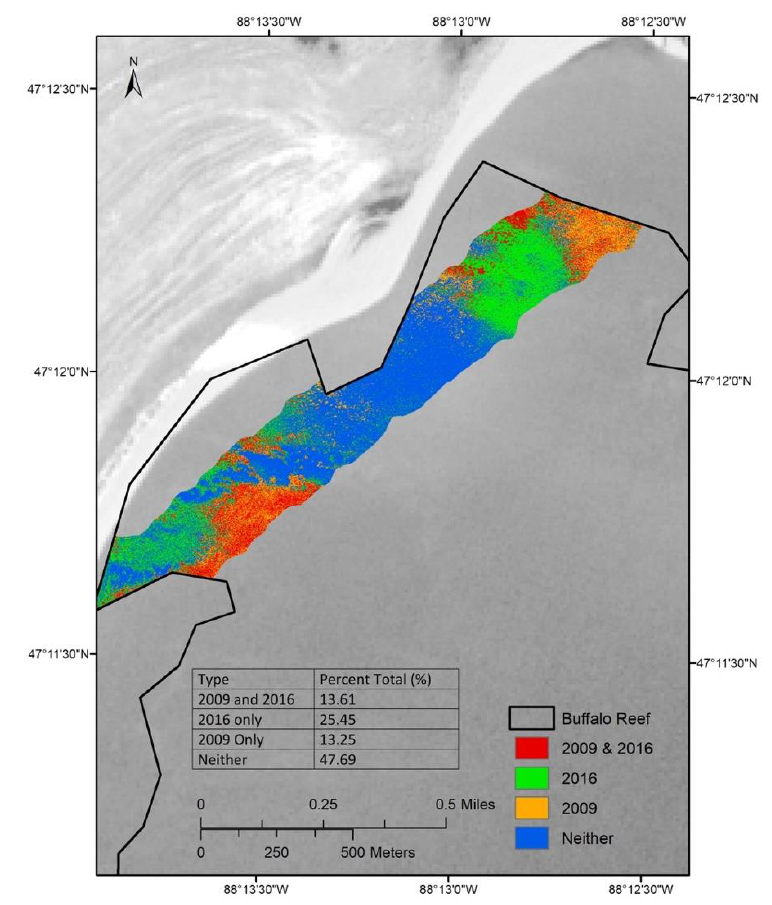
Figure 15. Bottom Type Change map, comparing classifications from 2009 NAIP image and 2016 CASI hyperspectral classified image. Expanding stamp sand cover (green) is indicated in both northeastern and southwestern regions. Percentage area change is given in chart inserted within figure. Table 3. Matches between reflectance-derived substrates and ground-truth observed substrates. Observed substrates are based on a combination of Ponar plus ROV ground-truth sites.